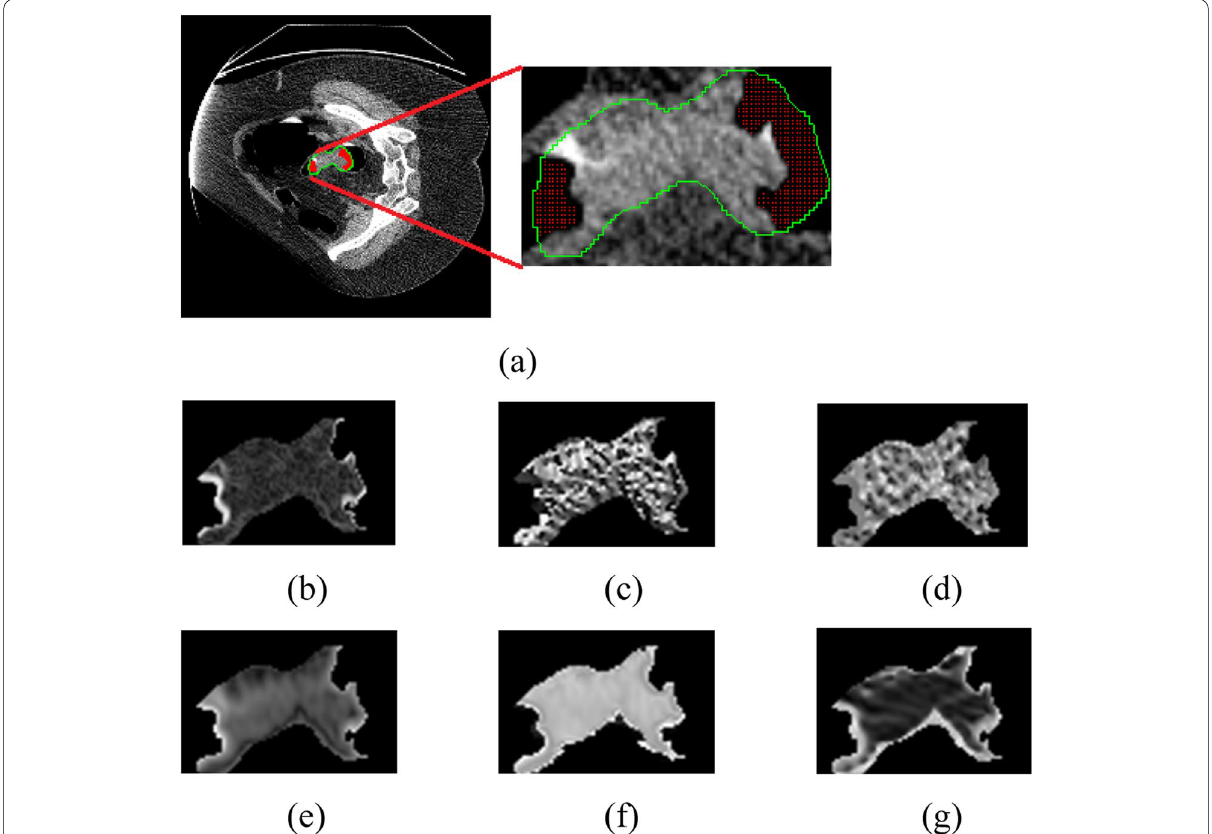
Fig. 5 Sample slices of one polyp showing the different output variables with gray scale 256. ( a ): Original intensity; ( b ): Gradient magnitude; ( c ): Gradient azimuth angle; ( d ): Gradient polar angle; ( e ): Eigenvalue magnitude; ( f ): Eigenvalue azimuth angle; ( g ): Eigenvalue polar angle